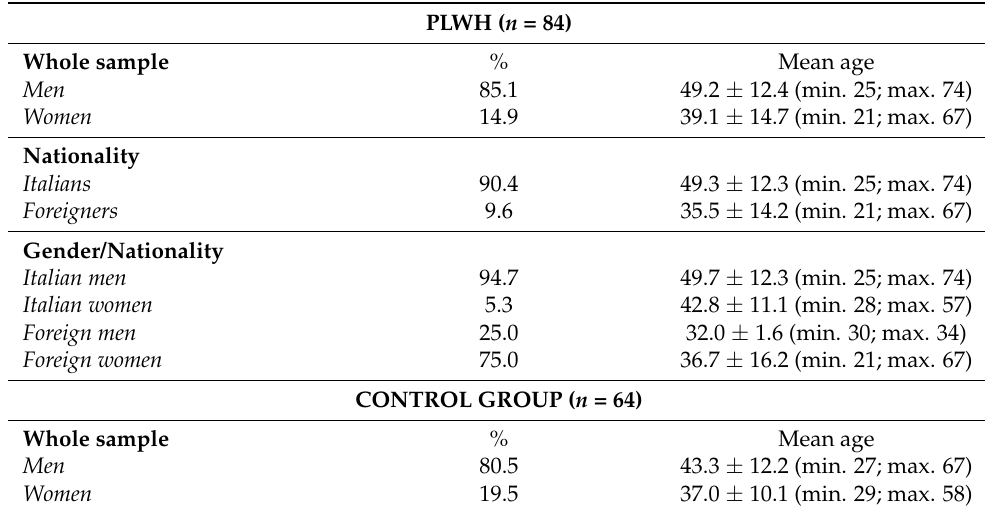
Table 1. Composition of the samples according to mean age, gender and